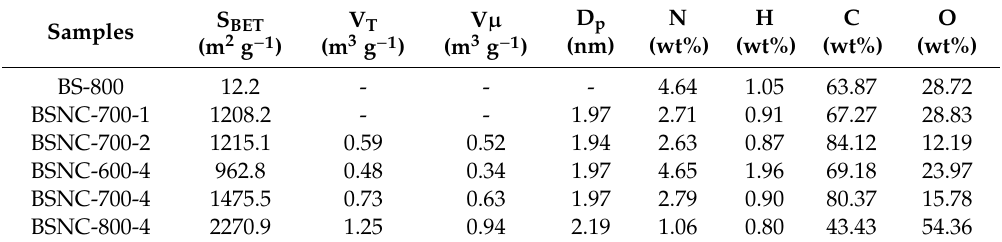
Figure 2. ( a ) Nitrogen adsorption/desorption isotherms and ( b ) pore size distribution of BSNC-600-4, BSNC-700-4 and BSNC-800-4. Table 1. Porosity properties and chemical composition of BSNCs.